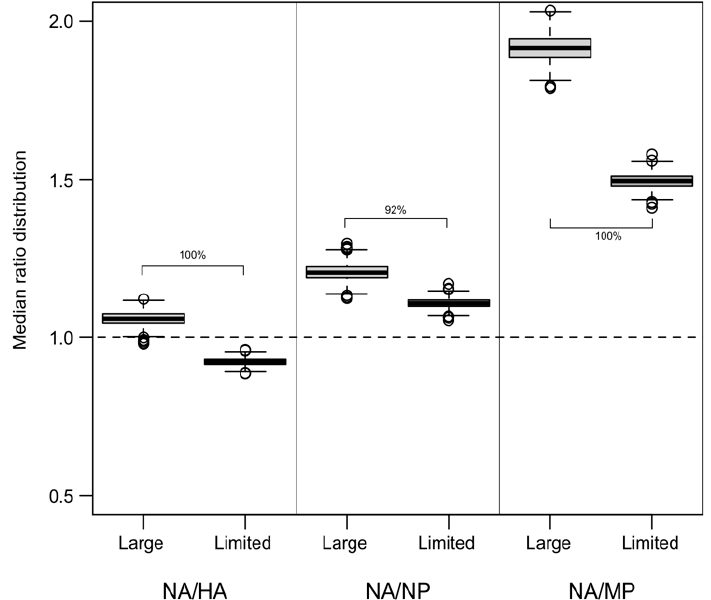
Figure 2. Median ratios distribution obtained from 1000 random extraction procedures (see Materials and Methods section for details). The percentage reported on cohort comparison indicates the proportion of significant ( p < 0.01) results.